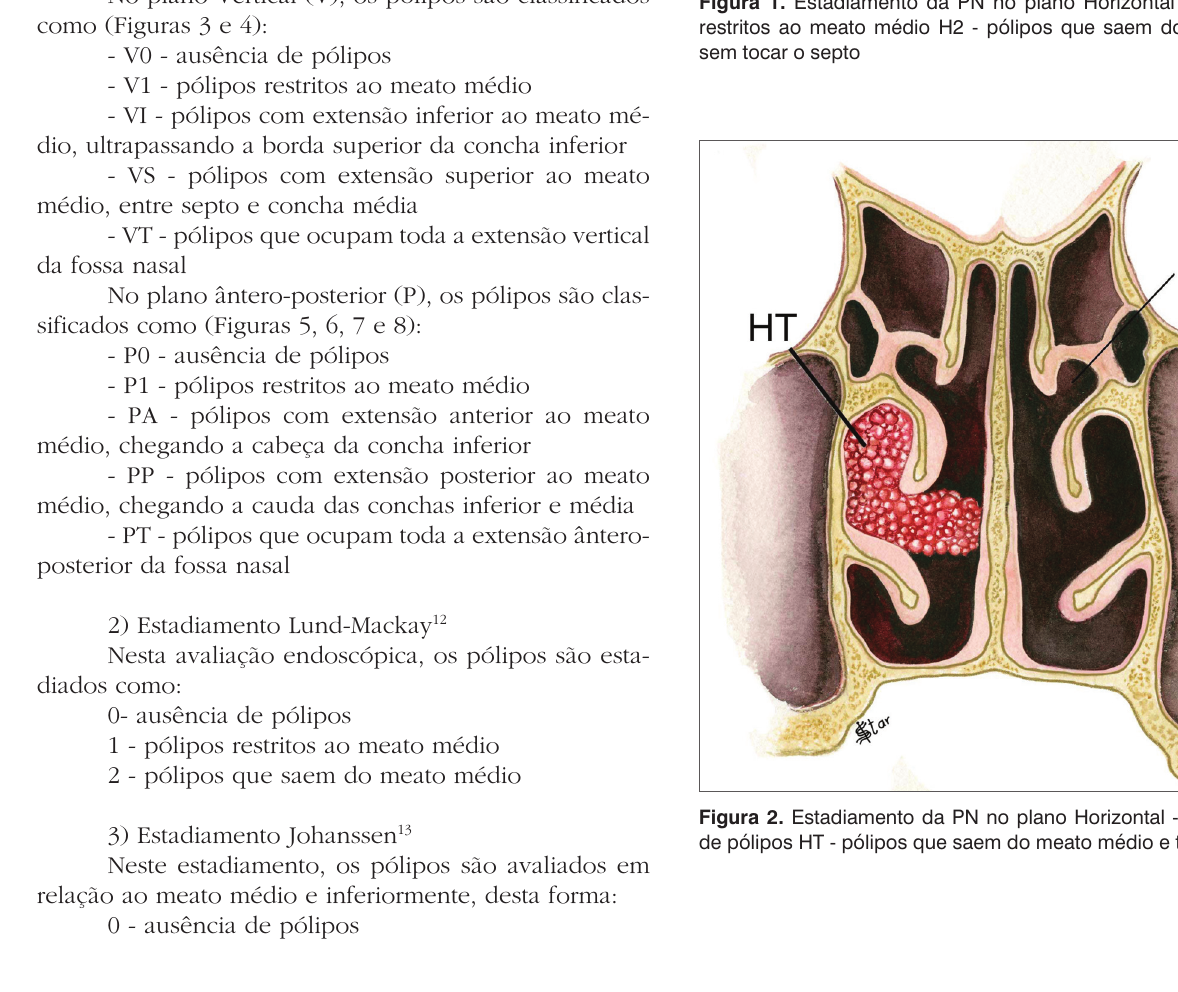
Figura 1. Estadiamento da PN no plano Horizontal - H1 - pólipos